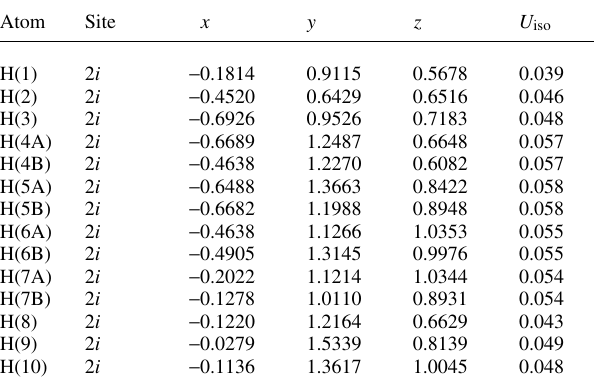
Table 2. Atomic coordinates and displacement parameters (in Å 2 ) .